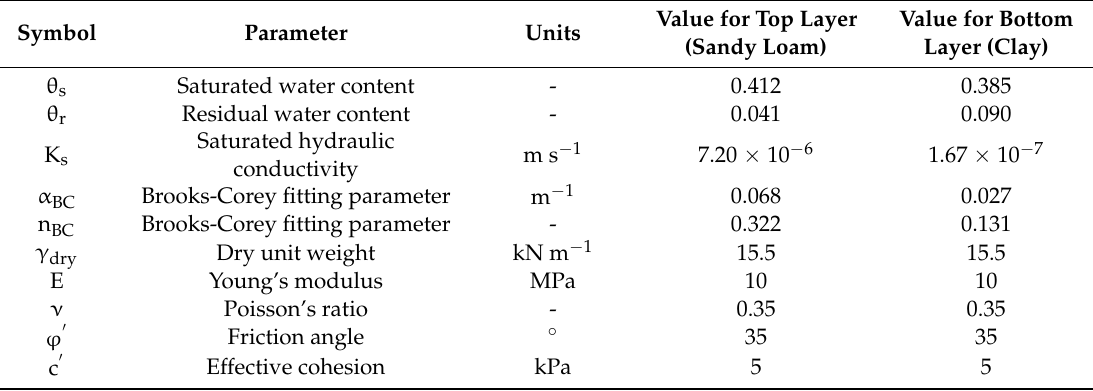
Figure 6. ( a ) The surface geometry of the 3D slopes, ( b , c ), the bedrock topography of the 3D slope C and D, ( d ) cross-section I through the 3D slope with boundary conditions, and ( e ) cross-section II through the 3D slope. Arrows are used to indicate dimensions. Table 2. Soil model parameters for the 2D and 3D numerical experiment (Slope A–D).